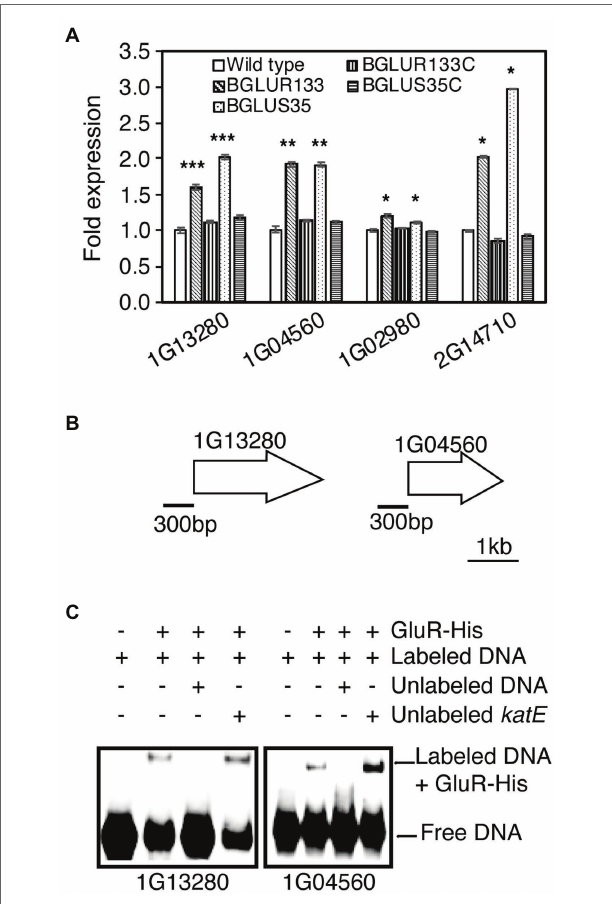
FIGURE 4 | The β -lactamase expression levels in B. glumae BGR1 strains. (A) Quantitative reverse-transcription PCR (qRT-PCR) analysis of the indicated β -lactamase genes was conducted for the WT BGR1, gluS mutant (BGLUS35), gluR mutant (BGLUR133), and their respective complemented mutant strains (BGLUS35C and BGLUR133C). Data are mean ± SE of triplicate experiments. Statistical analysis was performed using one-way ANOVA followed by Tukey’s test for multiple comparisons (* p < 0.05; F 19,40 = 3,924.655, p = 0.00). NS, not significant. (B) Gene map showing the putative promoter region of the metallo- β -lactamase (MBL) gene BGLU_1G21360 used in the electrophoretic mobility shift assay (EMSA). (C) EMSA results showing direct binding of GluR-His to the putative promoter region of BGLU_1G21360; 2 μ M GluR-His, 2 nM labeled target DNA, 2 nM unlabeled katE non-competitor DNA, and 20 nM unlabeled target promoter DNA were used for EMSA.